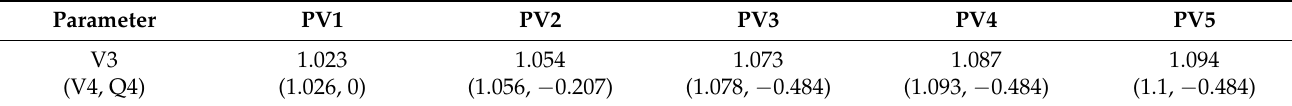
Table 2. Optimized droop se tt ing according to [16].